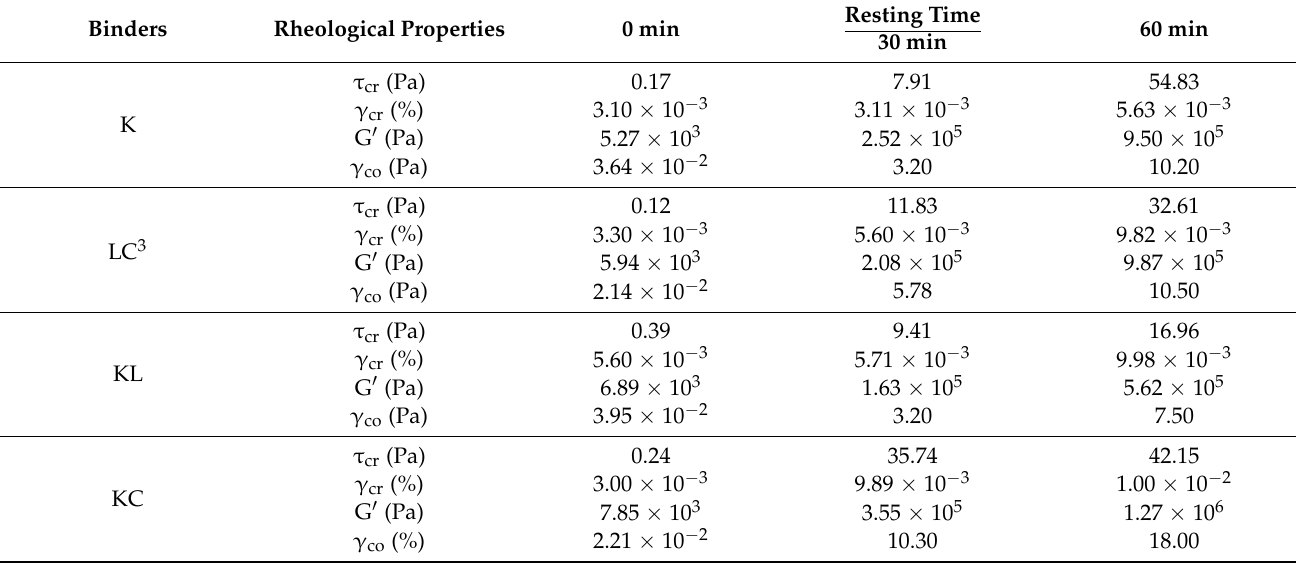
Table 6. Summary of the rheological properties obtained from the oscillation regime for binders at different resting times. Binders Rheological